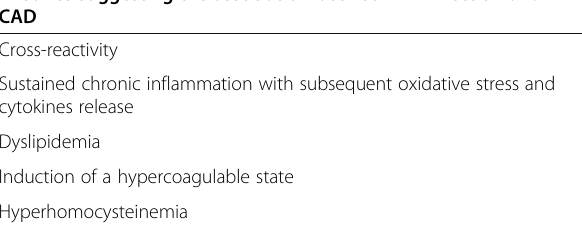
Table 1 Theories of the association between HP infection and CAD Theories suggesting the association between HP infection and CAD Cross-reactivity Sustained chronic inflammation with subsequent oxidative stress and cytokines release